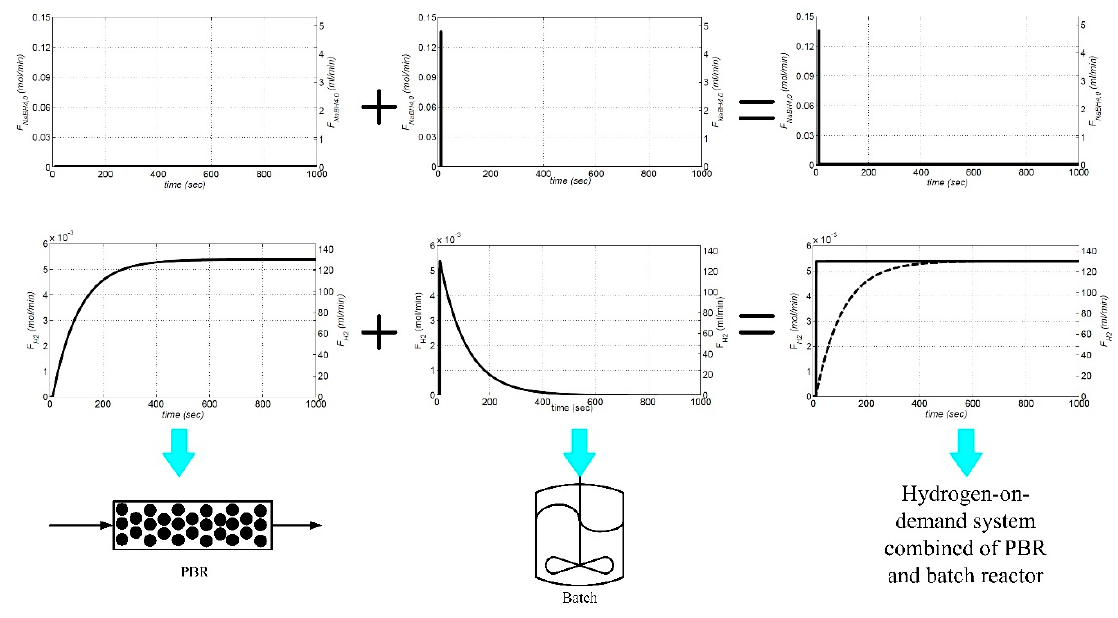
Figure 7. An instantaneous hydrogen generation rate obtained by the combination of impulse function (batch reactor) and pulse function (PBR) of the NaBH 4 feed flowrate.